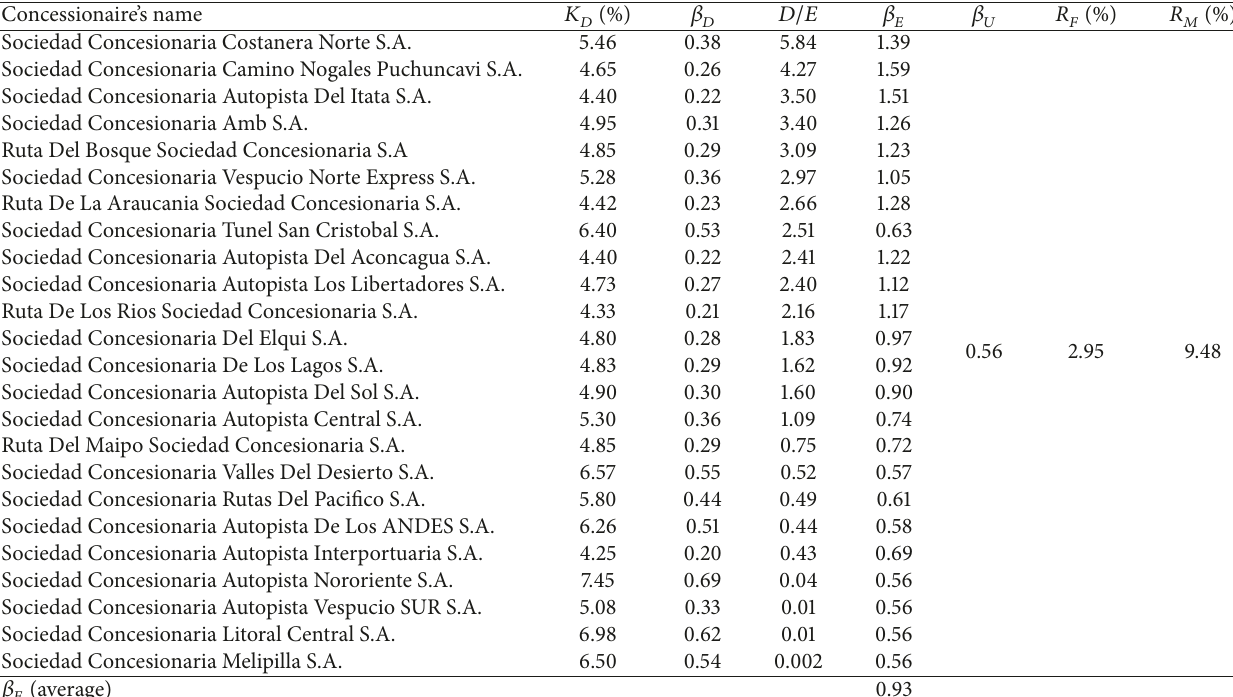
Table 5: Betas of equity for highways concessionaires in